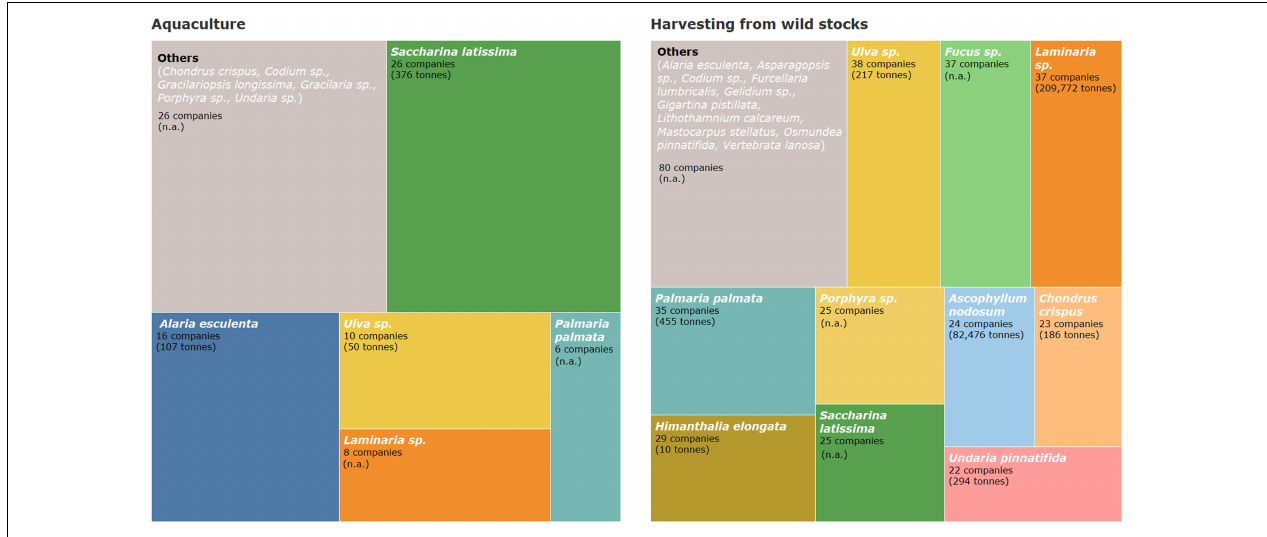
FIGURE 8 | Share of number of companies by macroalgae species produced in aquaculture and wild stock harvesting systems in Europe. Examples of the produced species included in the category “Others” are given. Production volumes per year by species are given whenever available (all numbers are in fresh weight). Volumes of production are estimated based on FAO (2020), national and regional statistics authorities and information from the industry.